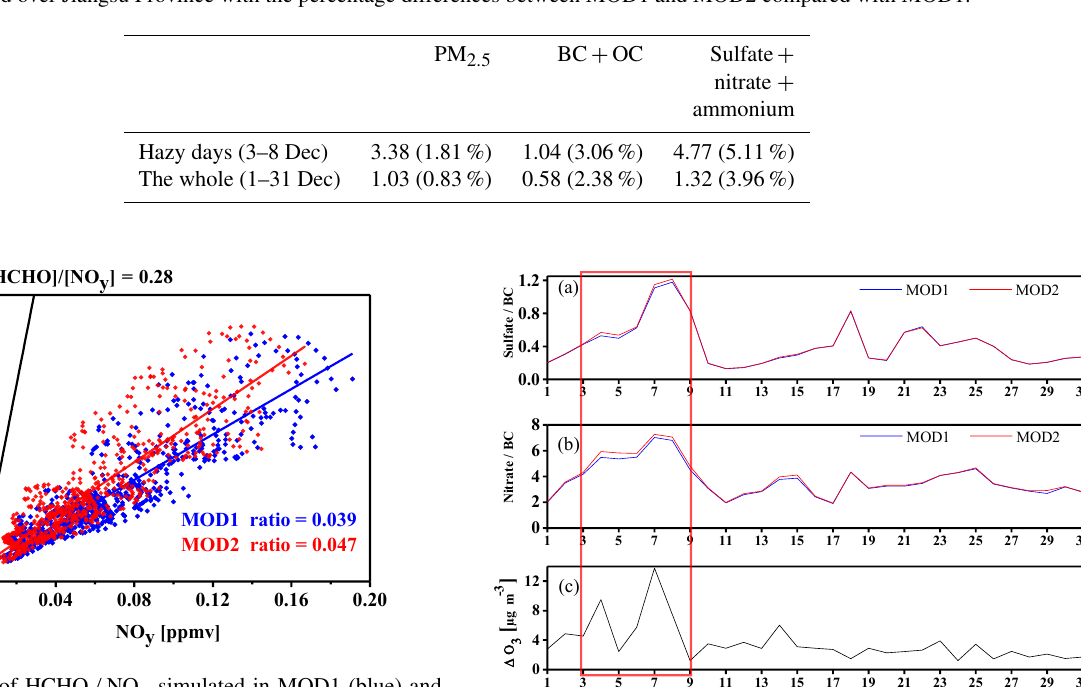
Table 5. Increased concentrations (µgm − 3 ) of PM 2 . 5 , total of BC and OC, and total of SOA (sulfate, nitrate, and ammonium) from MOD1 to MOD2 averaged over Jiangsu Province with the percentage differences between MOD1 and MOD2 compared with MOD1.